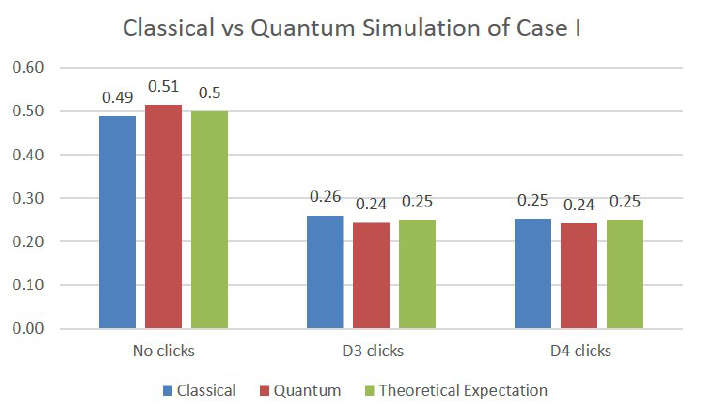
Figure 5. Simulations results for Case